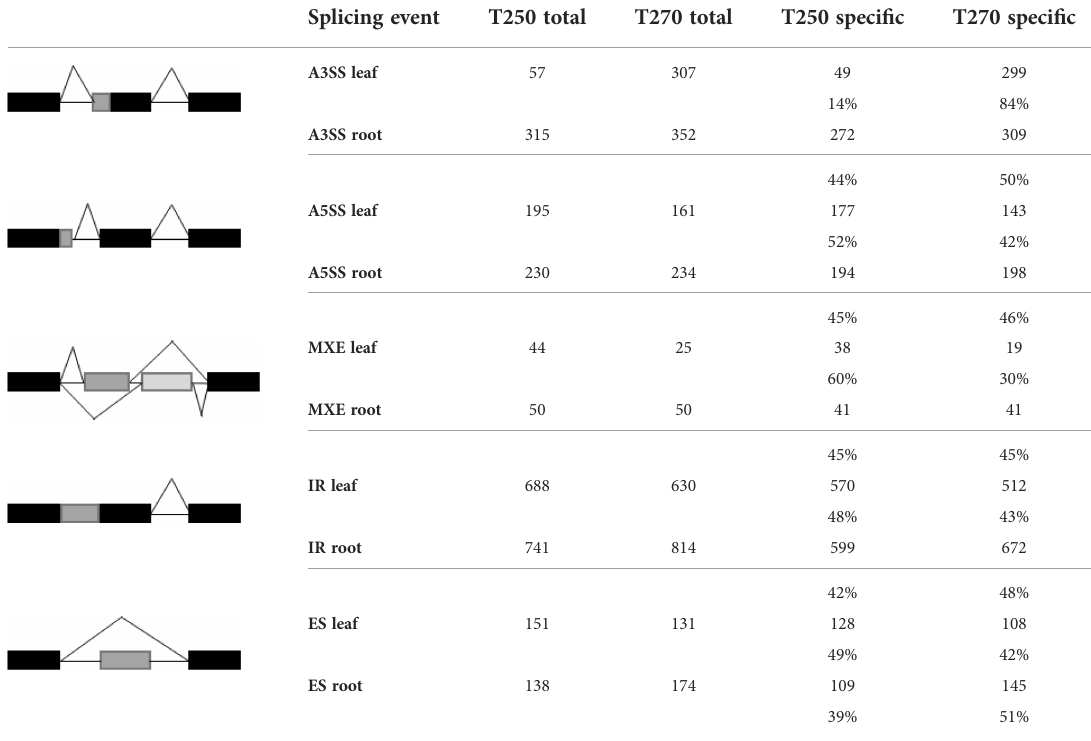
TABLE 3 Number of shared and genotype-speci fi c transcripts subjected to each of the fi ve splicing types of event in T250 and T270 leaf and root.